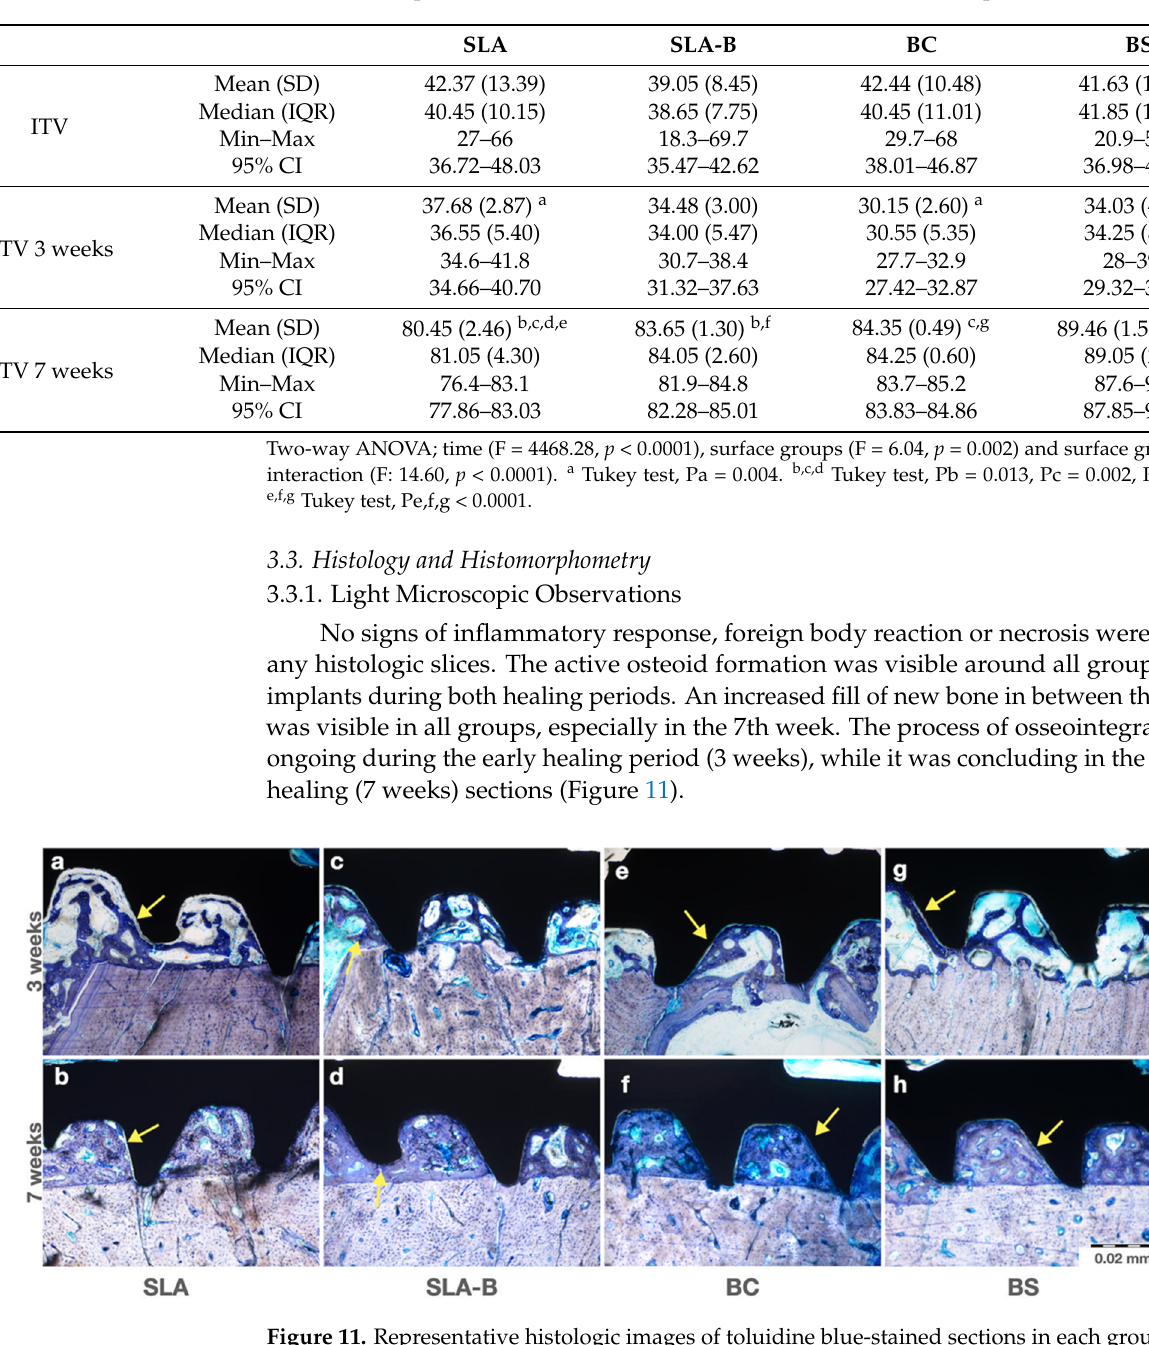
Table 4. Descriptive statistics of the measured insertion and removal torque values (ITV and RTVs).